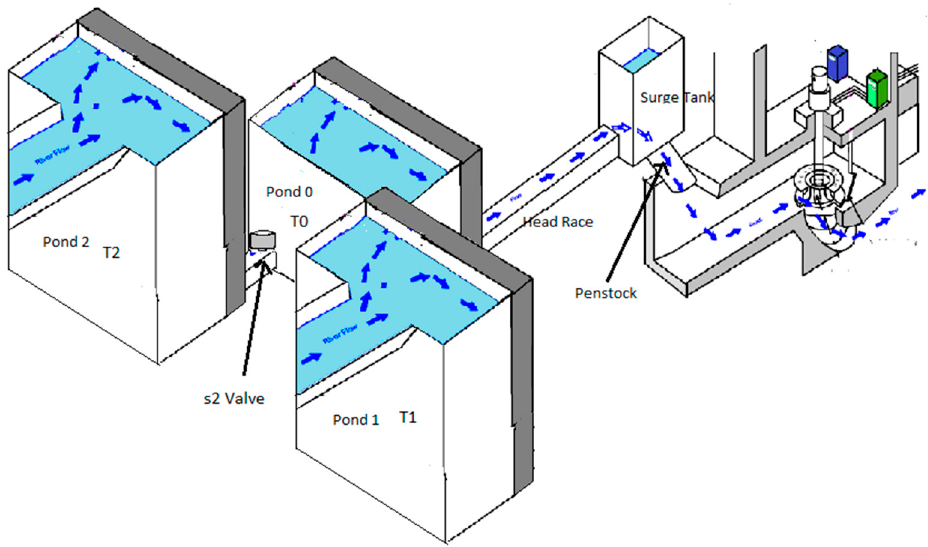
Figure 1. Proposed Three-Pond run-of-river hydropower plant.